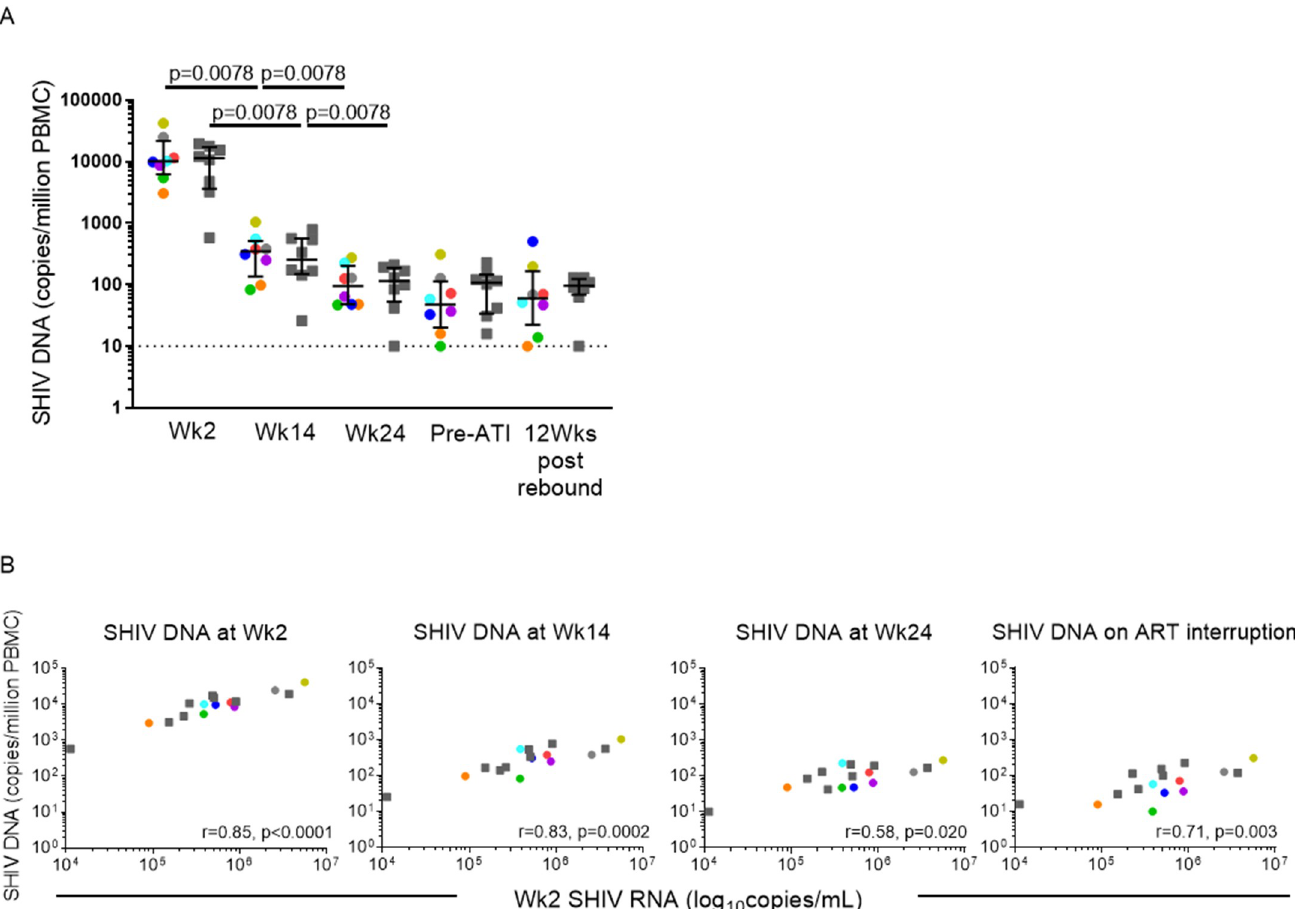
Fig 6. Impact of GS-986 and dual bnAbs on viral DNA levels. (A) Cell-associated viral DNA in PBMC was measured at wks 2 (pre-ART), 14 (pre-GS-986), 24 (2 wks after the 5 th dose of GS-986, before bnAb administration), immediately before ART interruption (pre-ATI) and at 12 wks post rebound. Data from animals in the active arm are displayed in color with each color corresponding to individual animals identified in Fig 4A. Data from animals in the control arm are displayed as gray squares. Dotted line represents LOQ of viral DNA assay. (B) Strong correlations were seen between SHIV RNA levels at wk 2 (pre-ART) with SHIV DNA levels at wk 2, wk 14, wk 24 and at ART